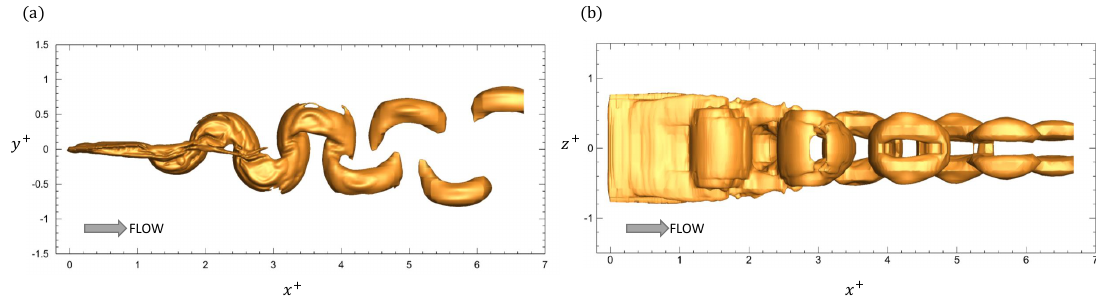
Figure 13. Iso-surfaces of vorticity magnitude ( | ω ∗ | = 1) in chordwise ( a ) and spanwise direction ( b ) respectively. The Reynolds number is 2000.